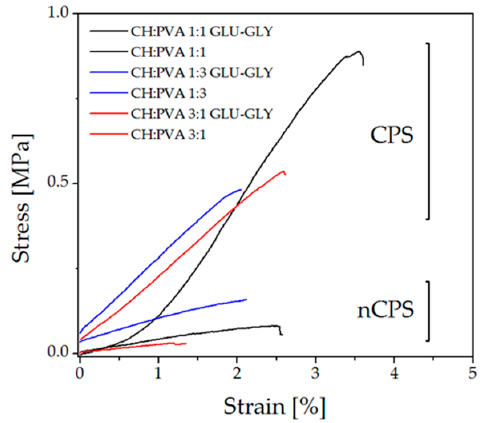
Figure 3. Tensile stress-strain curves for prepared samples.